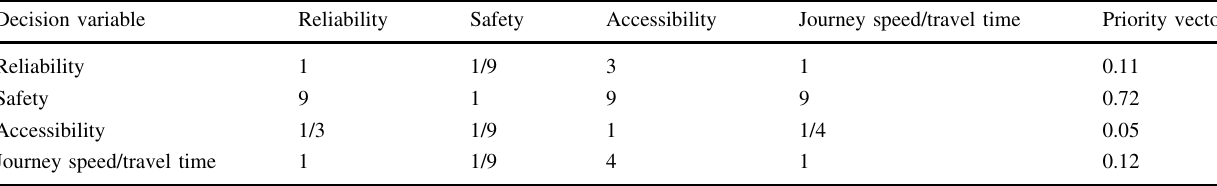
Table 5 Pairwise comparison matrix of user-oriented decision variables Decision variable